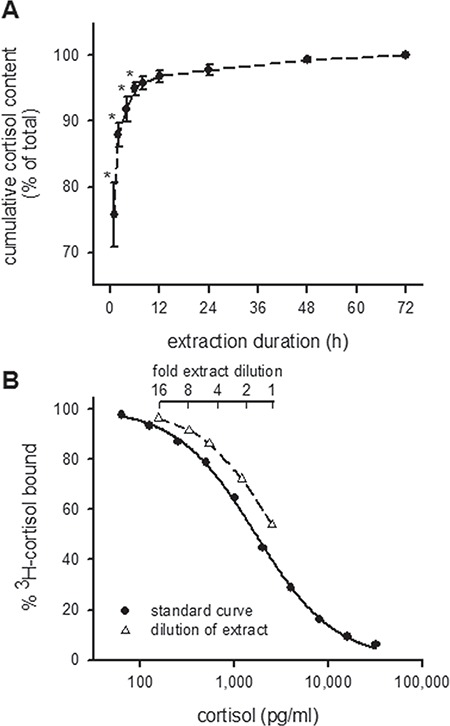
Extraction of cortisol from goldfish scales, and parallelism between diluted scale extract and RIA standards. (A) Relationship between extraction duration in methanol and percentage of total cortisol extracted from 50-mg scale samples over a 72-h incubation period (n = 5). Cumulative cortisol content values significantly lower than the 72-h extraction duration are indicated by asterisks. Data are mean ± SEM. (B) The displaced dilution curve of goldfish scale extract shows parallelism with the standard curve of the cortisol RIA